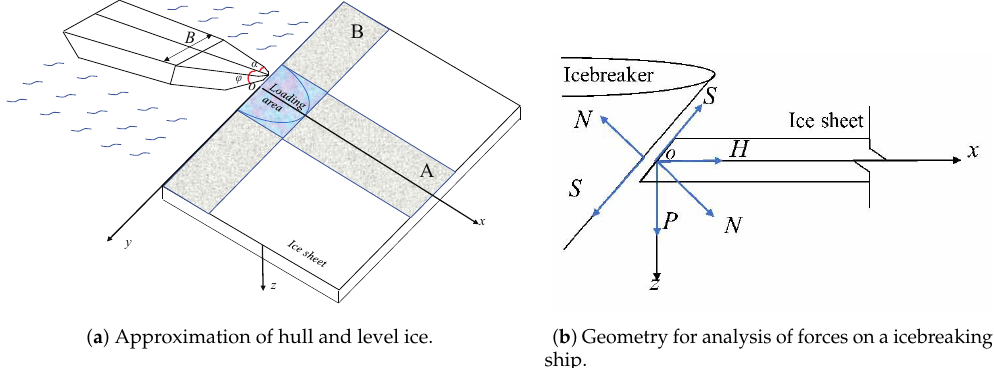
( b ) Geometry for analysis of forces on a icebreaking ship. Figure 1. Overall problem